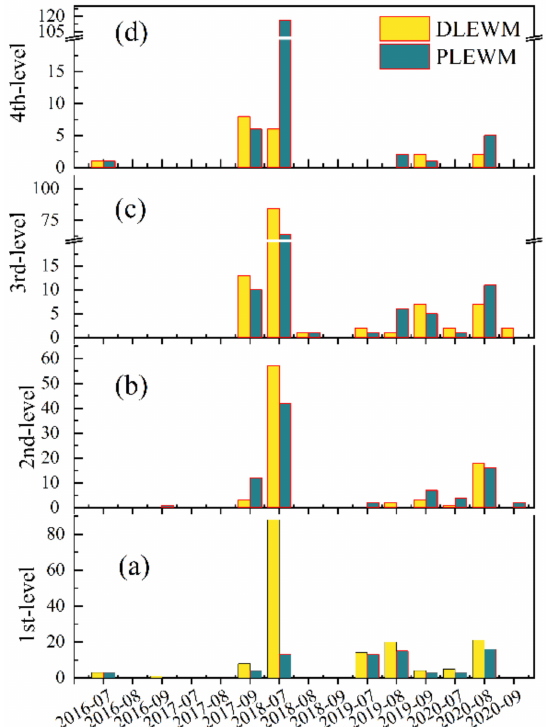
Figure 16. Number of landslides occurring within the warning zone at each level: ( a ) 1st-level, ( b ) 2nd-lvel, ( c ) 3rd-level, ( d )